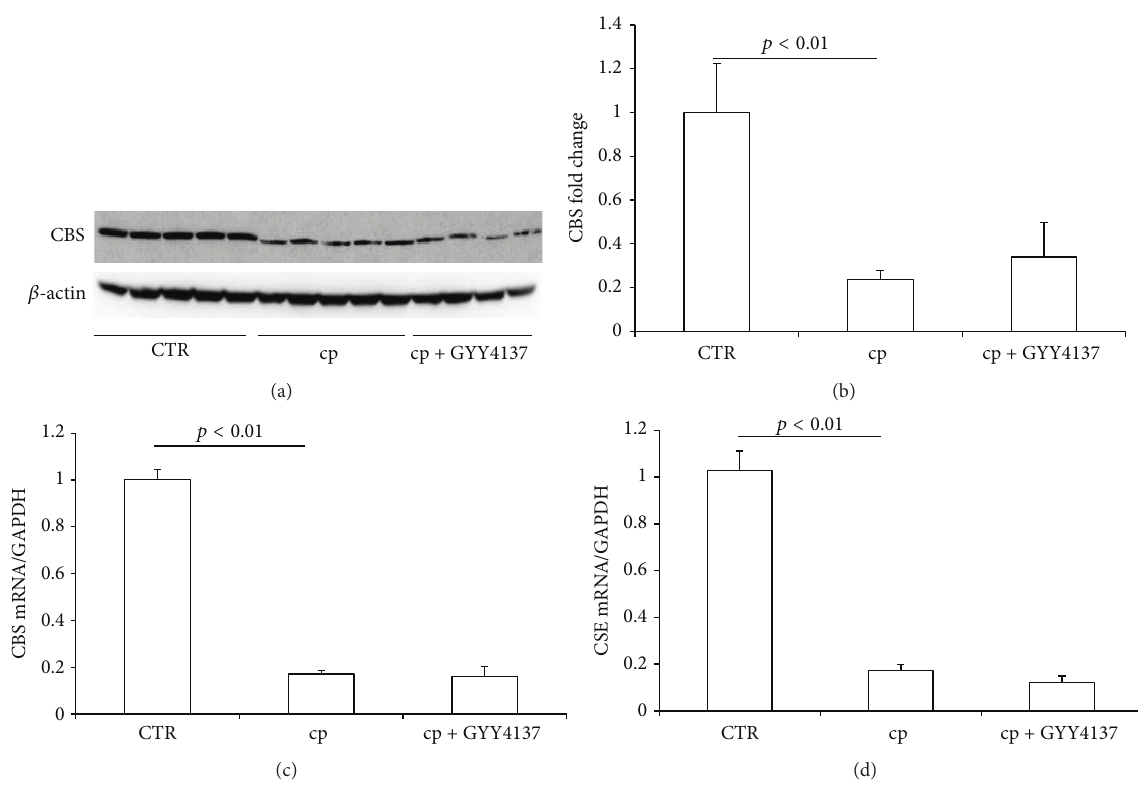
Figure 5: Effects of GYY4137 on CBS and CSE expression after cisplatin treatment. (a) Western blot analyses of CBS and 𝛽 -actin in kidney. (b) Densitometry of CBS. A densitometric ratio between the densitometry of CBS and 𝛽 -actin was calculated, and data are expressed in comparison with the controls. (c) qRT-PCR analysis of CBS. (d) qRT-PCR analysis of CSE. CTR: control, 𝑛 = 5 ; cp: cisplatin, 𝑛 = 10 ; and cp + GYY4137: cisplatin + GYY4137, 𝑛 = 10 . Data are means ±